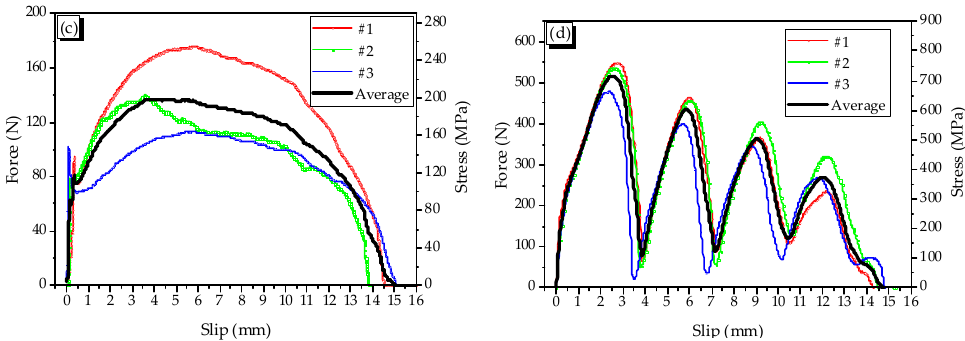
Figure 3. Pullout force–slip relation in non-heating and heating cases, ( a ) Non-heated dog-bone-shaped fiber, ( b ) Non-heated crimped fiber, ( c ) Heated dog-bone-shaped fiber ( d ) Heated crimped fiber. Table 1. Mixture composition of mortar matrix with the weight ratio.